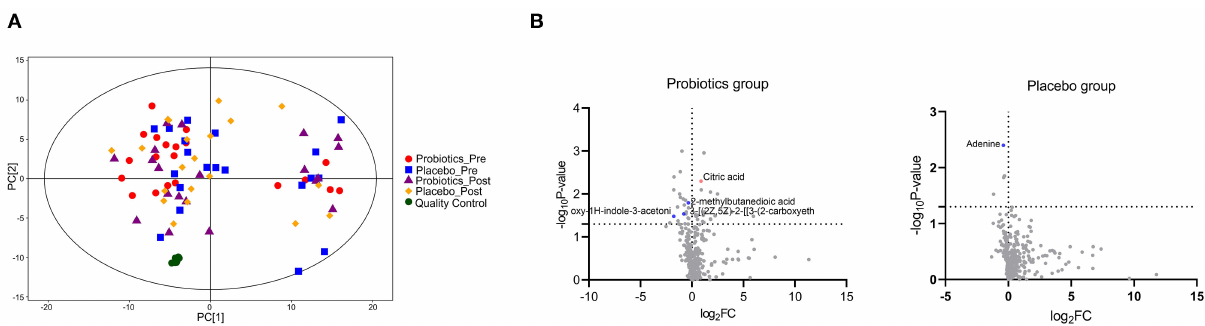
amino acids metabolism (e.g., Tyrosine metabolism), lipid metabolism (primary bile acid biosynthesis), carbohydrate metabolism (citrate cycle), and nucleotide metabolism (purine metabolism). The changes of Biliverdin dihydrochloride ( B = − 0.724, P = 0.02) were inverse correlated with the weight